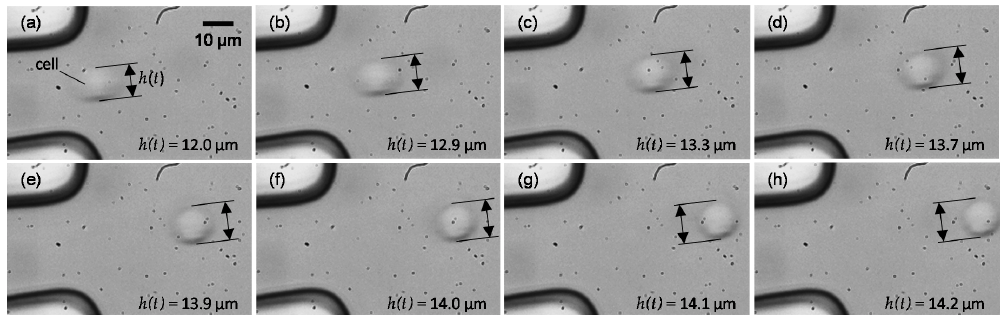
Figure 3. A time series of snapshots of a cell showing how the cell was recovering its shape after it had left the tip of the tapered channel ( a ). The time interval between consecutive snapshots ( b – h ) is 20 µ s. The scale bar in Figure 3a applies to all images.